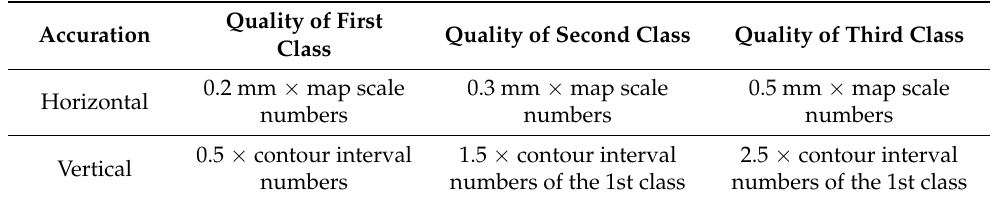
Table 2. Geometric accuracy requirements on the national topographic map of Indonesia based on the quality